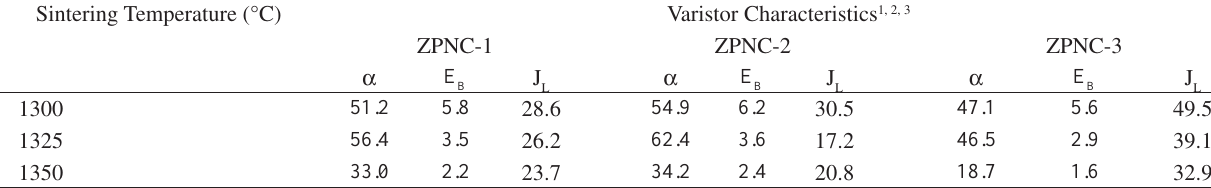
Table 2. Varistor characteristics of investigated samples of the ZPNC system. Sintering Temperature